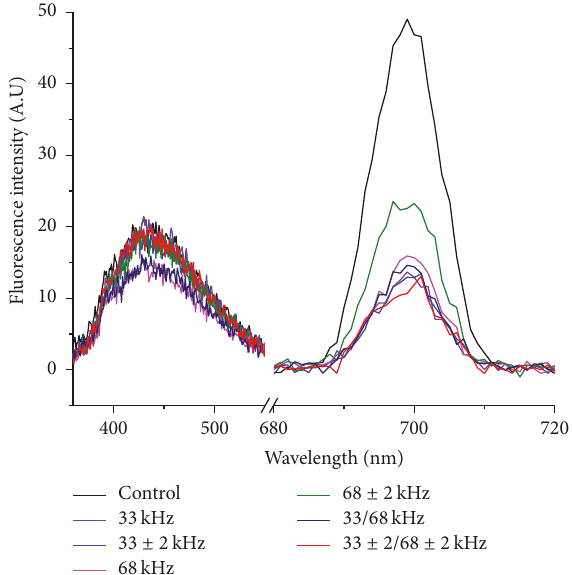
Figure 6: Effects of pretreatment with ultrasound bath with four different working modes and two frequencies on the intrinsic fluorescence spectra of